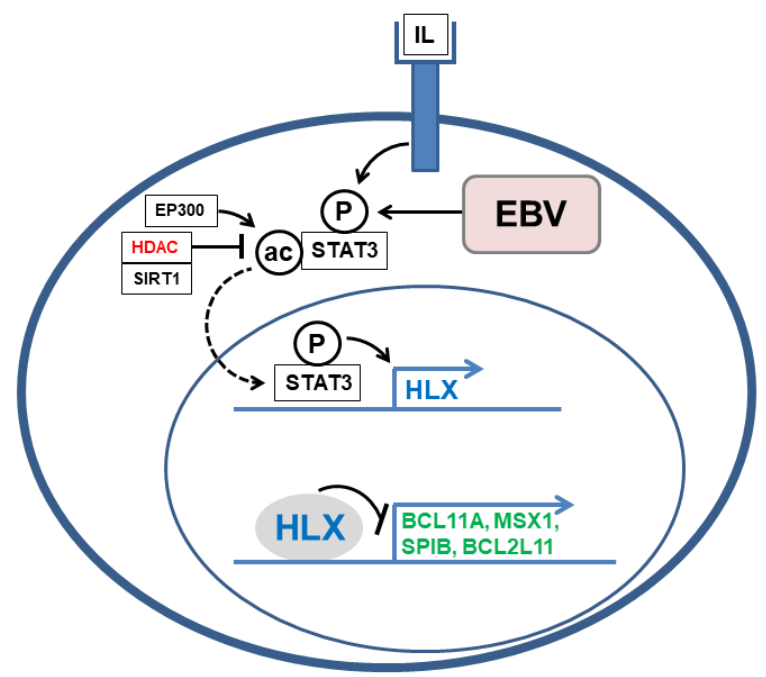
Figure 3. This diagram shows the regulation and function of aberrantly expressed NKL homeobox gene HLX. STAT3 is activated by interleukin (IL)-receptor-signaling or EBV-infection resulting in phosphorylation (P). The subcellular localization of STAT3 is regulated by acetylation (ac). EP300 mediates acetylation, while SIRT1 and overexpressed histone deacetylases (HDACs, red) perform deacetylation. Phosphorylated and deacetylated STAT3 translocate into the nucleus (dashed arrow) to activate its target gene HLX. HLX can in turn operate as a repressor to inhibit the target genes BCL11A, MSX1, SPIB, and BCL2L11 (green).